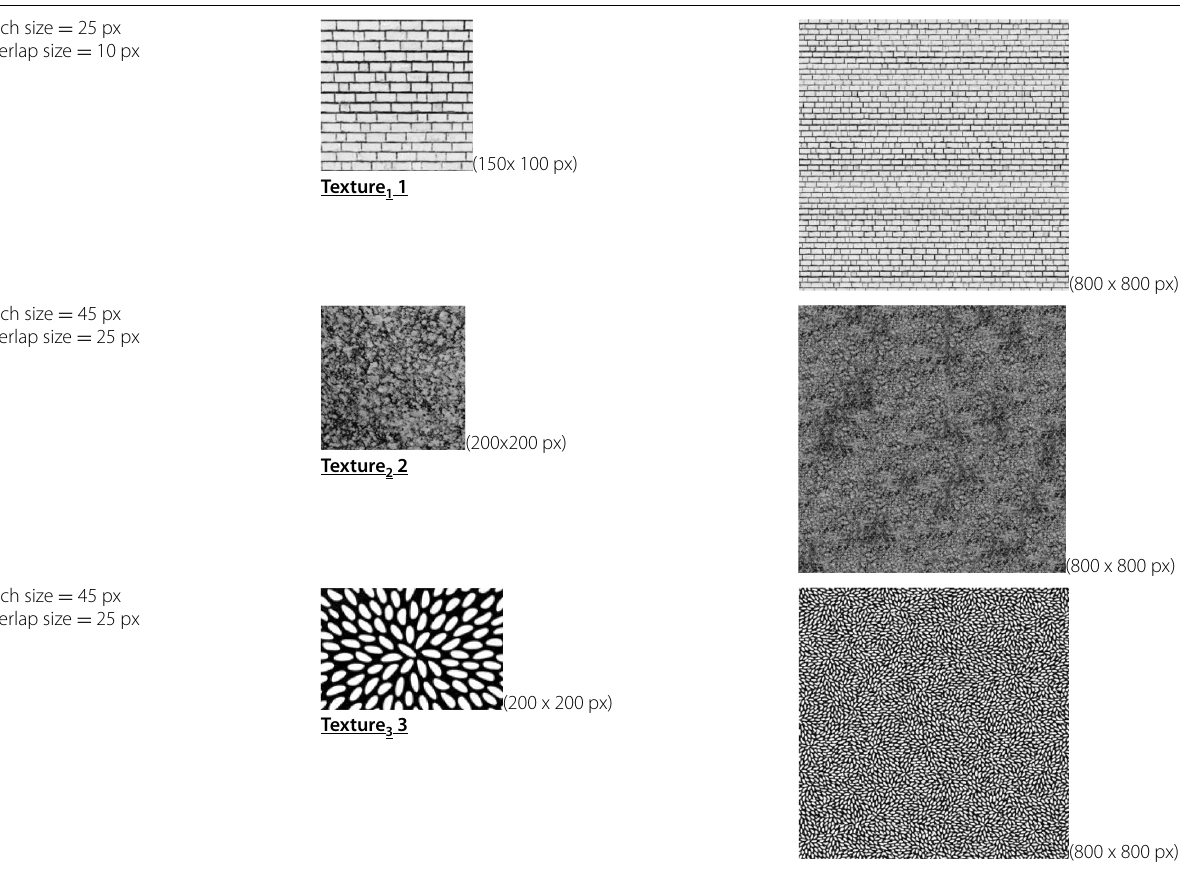
Table 1 Texture inputs and the generated results